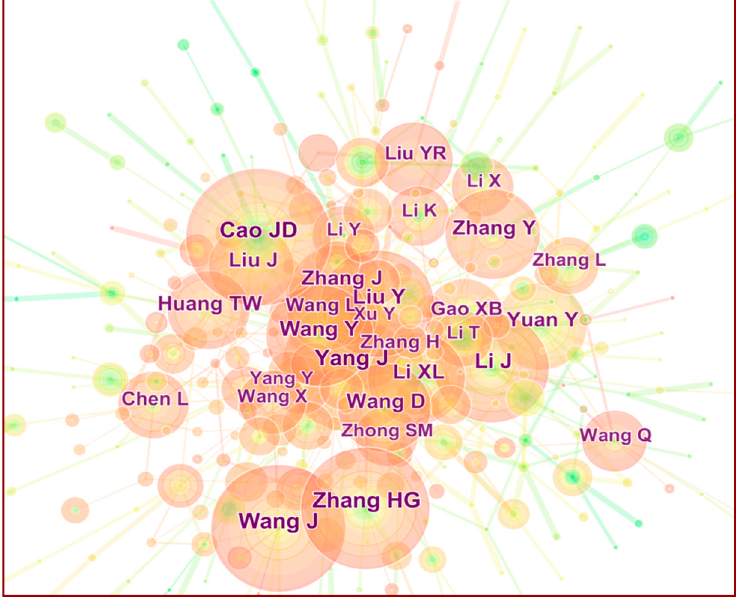
Figure 4. Author Co-Citation Analysis.